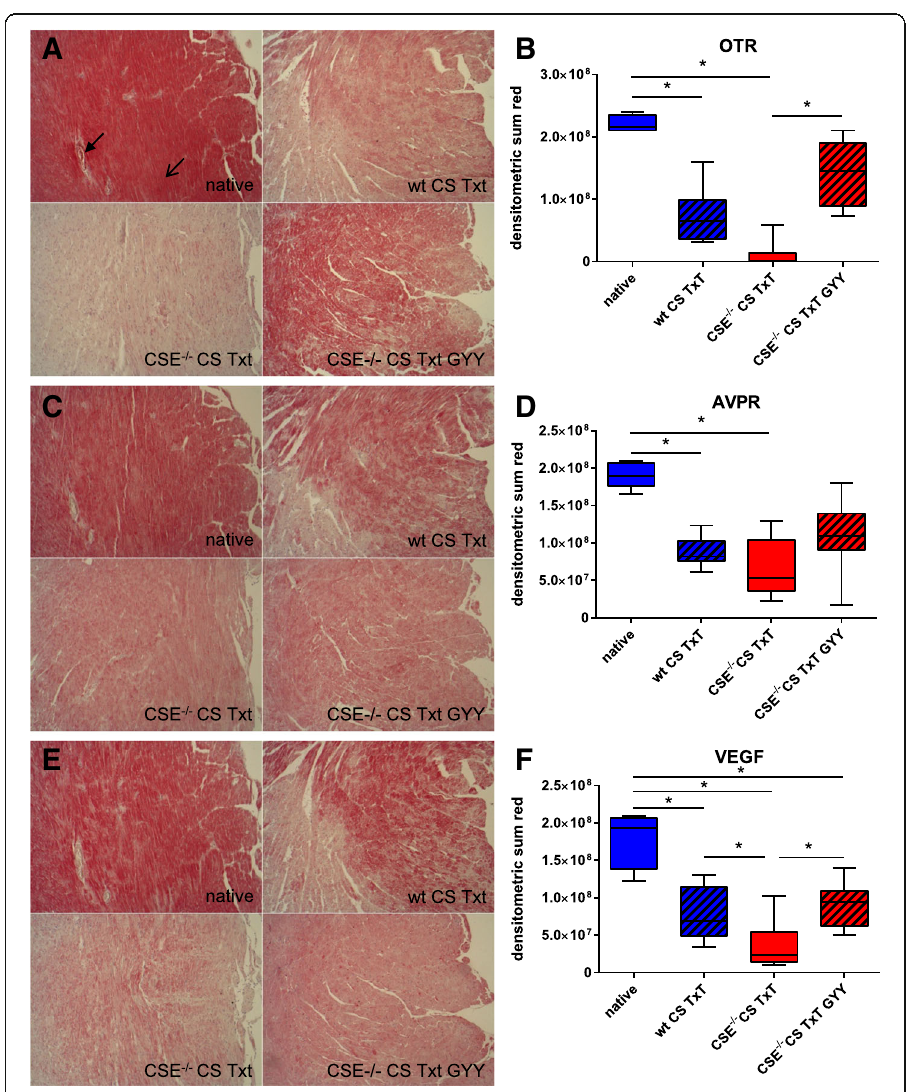
Fig. 1 Immunohistochemistry. Exemplary pictures (top left native, top right WT CS Txt, bottom left CSE − / − CS Txt, bottom right CSE − / − CS Txt GYY4137, respectively) of left-ventricular myocardium (ventricular lumen to the right) and densitometric analysis for OTR expression ( a , b ), AVPR expression ( c , d ), and VEGF expression ( e , f ). Data given as box plots (median, interquartile range, minimum and maximum). Boxplots represent N =4 (native) and N =8 (experimental groups). Open arrow cardiomyocyte, bold arrow cardiac